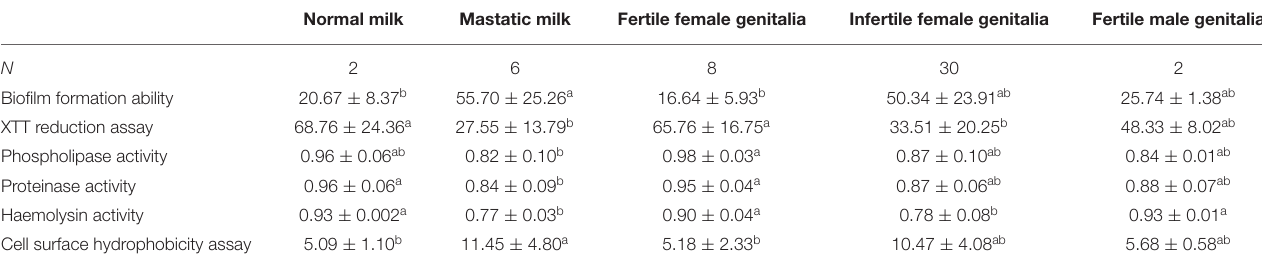
TABLE 2 | Biofilm formation ability, XTT reduction assay and phospholipase, proteinase and hemolysin activities, and cell surface hydrophobicity assay in the different animal groups (Mean ± Standard Deviation). Normal milk Mastatic milk Fertile female genitalia Infertile female genitalia Fertile male genitalia